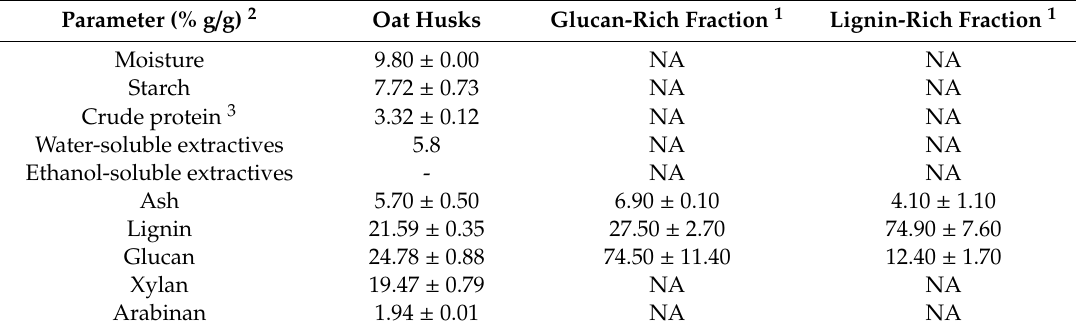
Table 1. Composition of untreated oat husks and glucan-rich and lignin-rich fractions obtained at the ideal pretreatment conditions that were identified in this study. Parameter (% g / g)